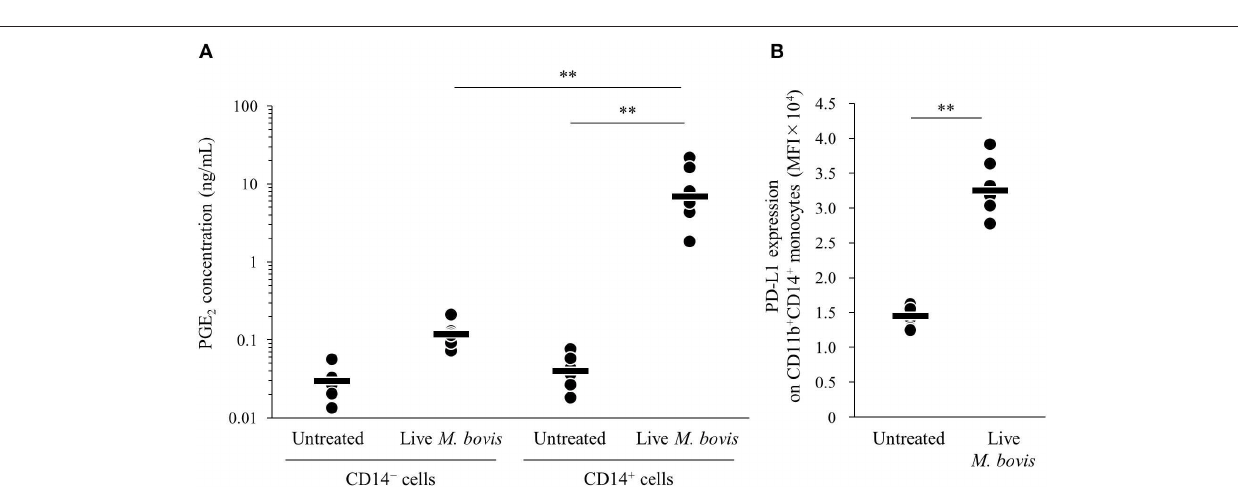
FIGURE 2 | PGE 2 production from CD14 + cells induced by M. bovis . CD14 + cells or CD14 − cells from uninfected cattle were incubated with live M. bovis (MOI of 10) for 24h. (A) PGE 2 production was determined by ELISA (CD14 − cells untreated: n = 6, CD14 − cells Live M. bovis : n = 6, CD14 + cells untreated: n = 6, CD14 + cells M. bovis : n = 6). (B) PD-L1 expression on CD14 + cells (untreated: n = 6, live M. bovis : n = 6) was determined by flow cytometry. The bars are the median of the values (A,B) . Statistical significance was determined by the Steel–Dwass test (A) or Mann–Whitney U -test (B) . ** P <